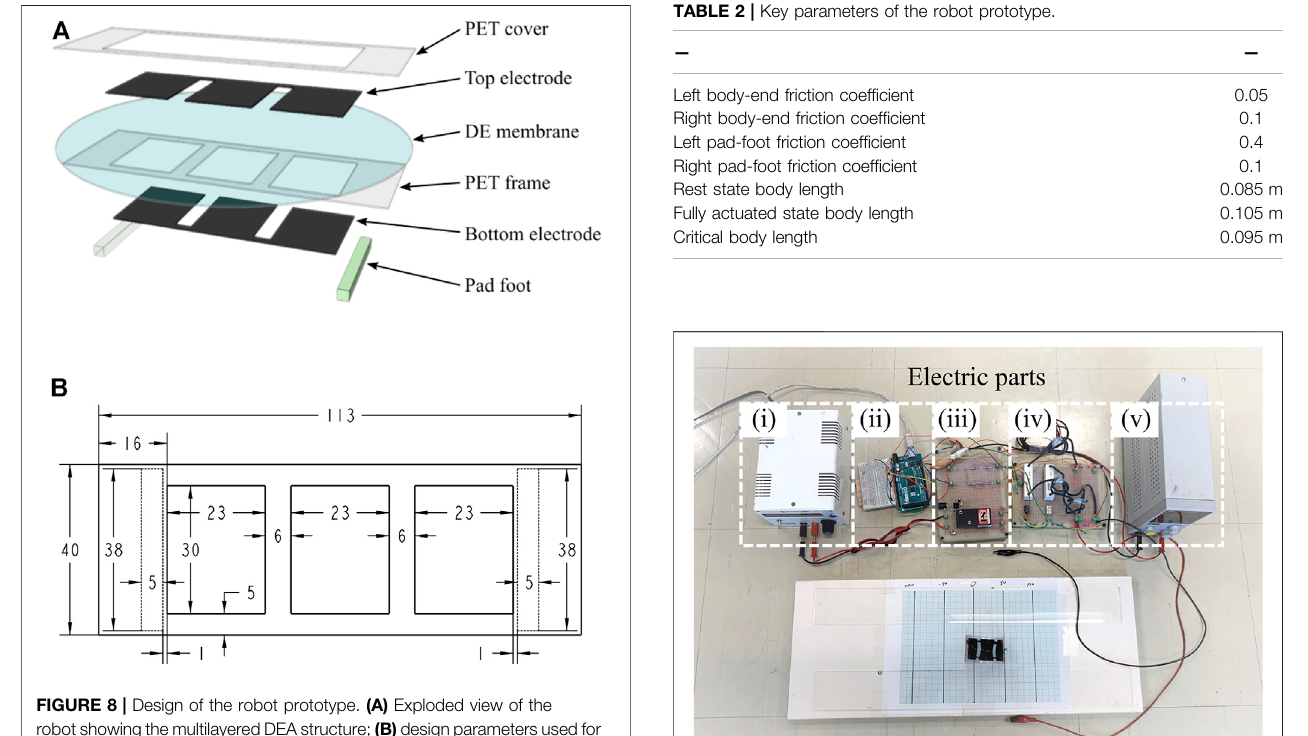
( Figure 1 ). The PET frame and DE membrane weighed about